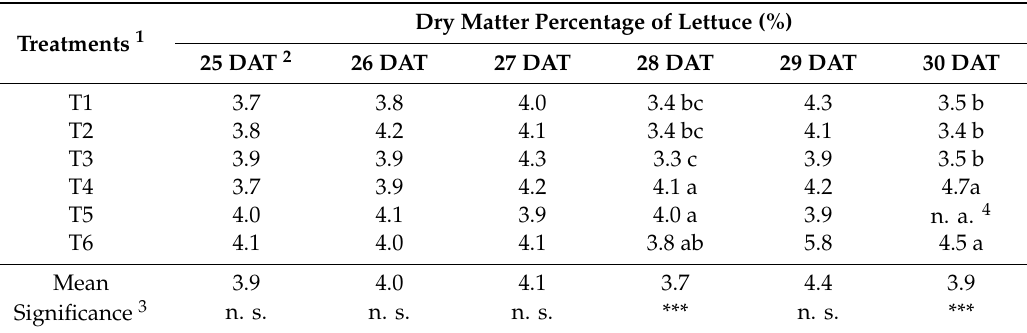
Table 4. Autumn trial: dry matter content in lettuce per type of fertilization treatment. Treatments 1